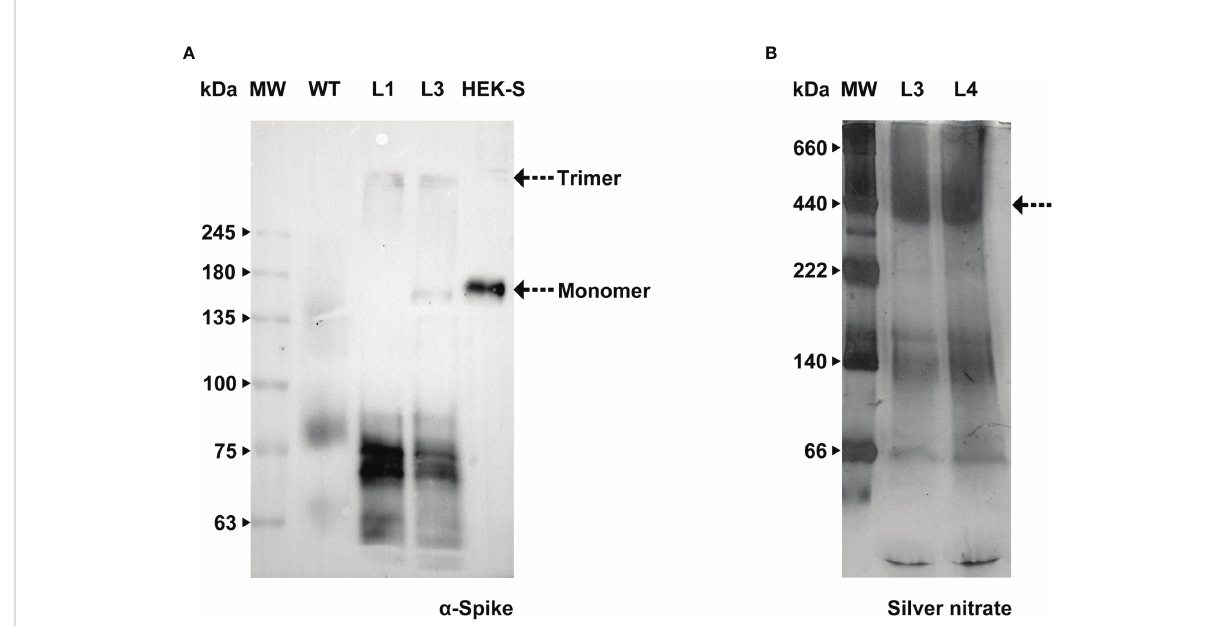
FIGURE 7 Assessment of Spike native conformation in BY-2 cell lines. (A) WB analysis with anti-Spike antibody of total protein extract, carried out under non-reducing conditions, from two independent BY-2 cell lines (L1 e L3), WT – wild type, HEK-S -Spike produced in HEK cell lines (Castro et al., 2021). (B) Stained gel containing spent medium of two independent BY-2 cell lines (L3 e L4) carried out under native